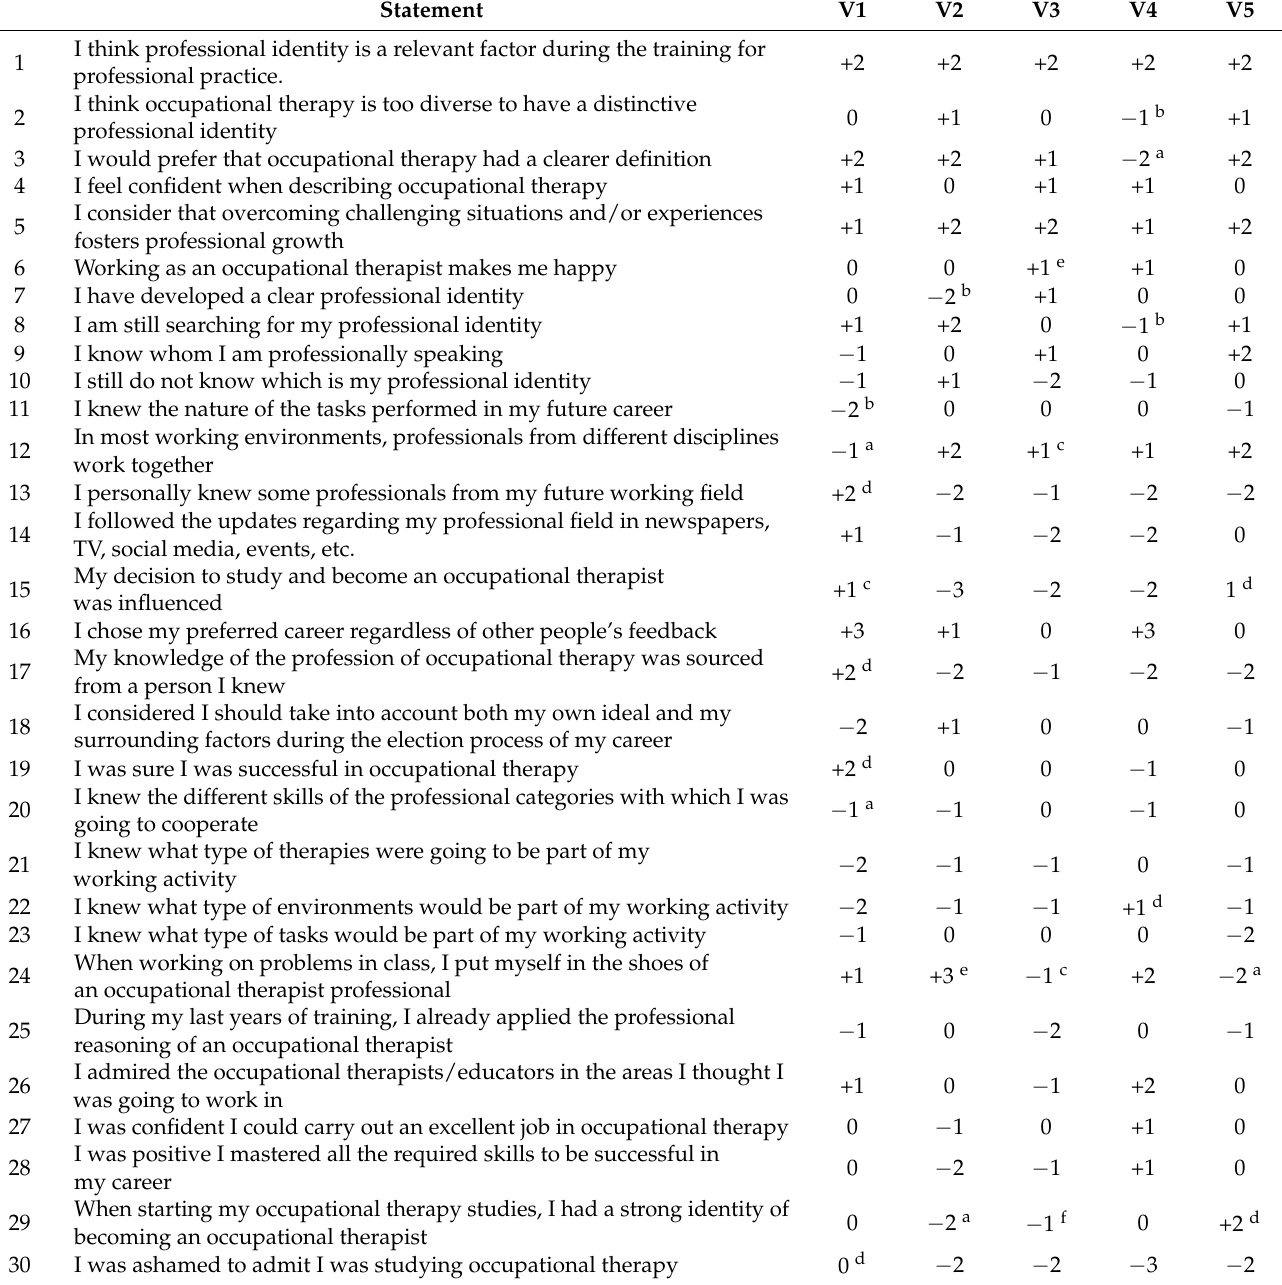
Table 4. Complete list of 40 Q-sort statements and idealised sorts for the five